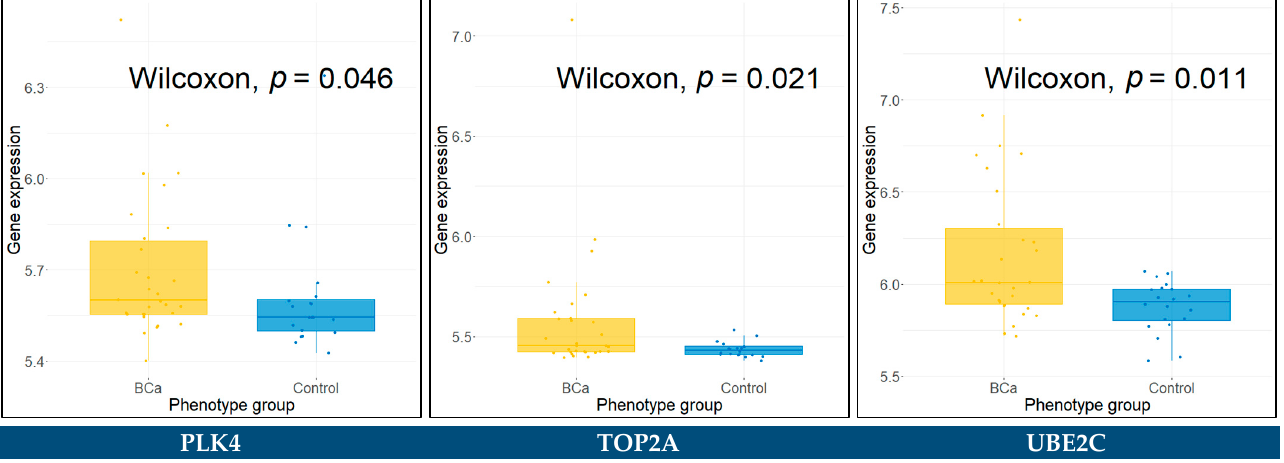
Figure 12. Significantly differentially expressed key hub genes in urine samples using the Wilcoxon rank sum test in GSE68020 ( n = 50).